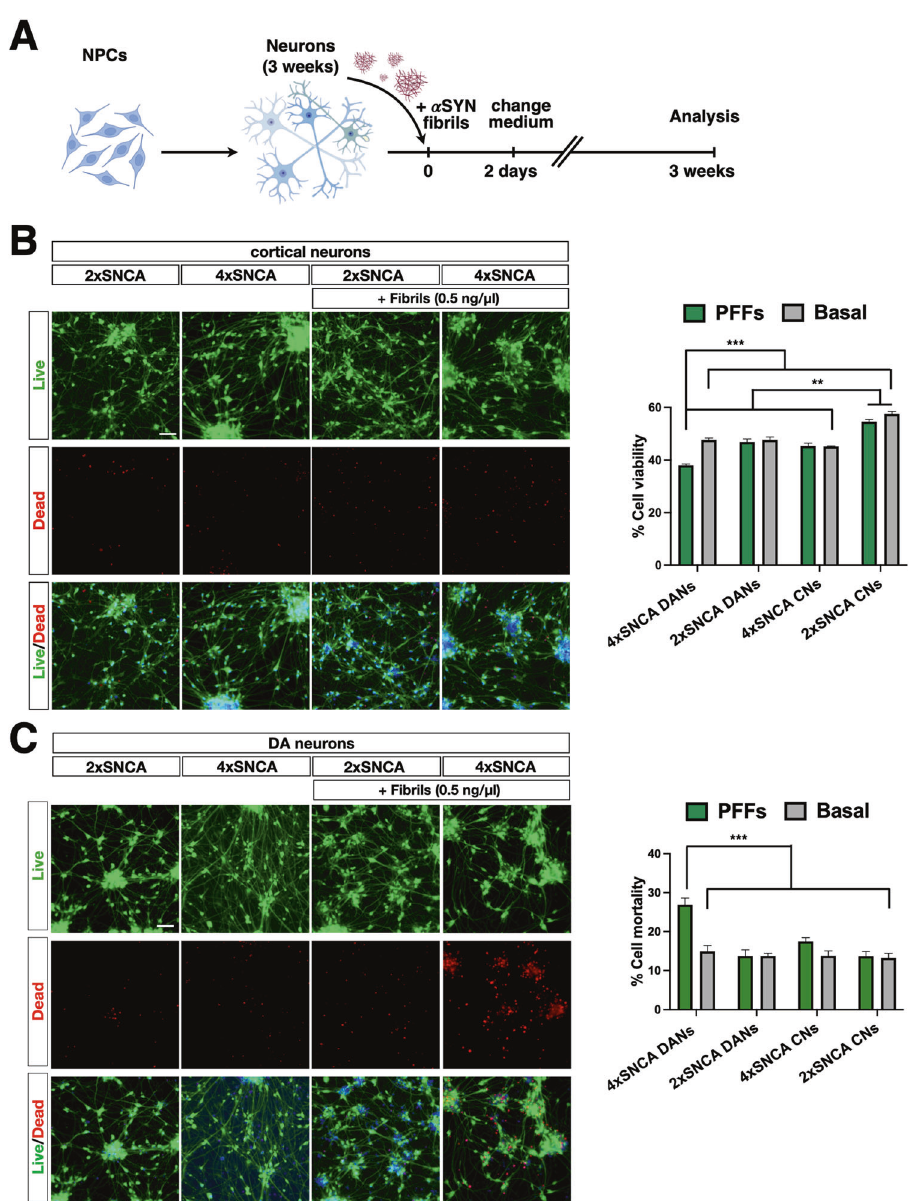
Fig. 5 Impaired survival of 4xSNCA mDA neurons exposed to fi brils. A Schematic view of the protocol to intoxicate cortical and DA neuronal cultures with P91 α Syn fi brils. B Live/dead fl uorescence staining and quanti fi cation of iPSC-derived cortical neurons with or without exposure to P91 fi brils. C Live/dead fl uorescence staining in iPSC-derived DA neurons with or without exposure to P91 fi brils and relative quanti fi cation (for each group n = 50 fi elds, automatic counts). Values are mean ± SEM of n = 3 biologically independent experiments. ** p < 0.01, *** p < 0.001. Statistical analysis is performed using two-way ANOVA followed by the Bonferroni post-test. Scale bars, 100 µm.